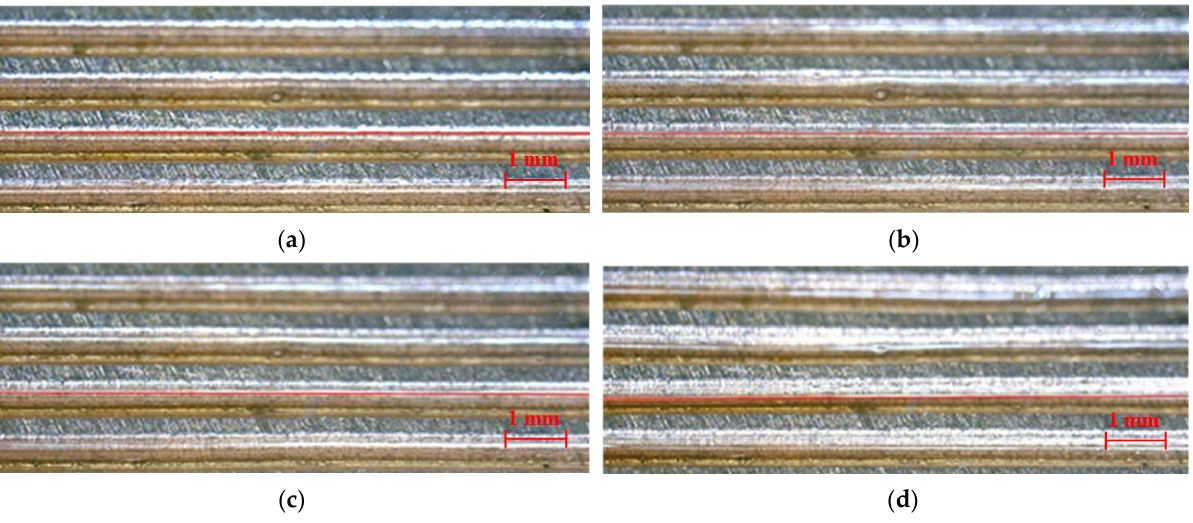
Figure 8. Formation of slope liquid level of the MGFHP filled with anhydrous ethanol under 12 W: ( a ) 1 s; ( b ) 80 s; ( c ) 160 s; and ( d ) 240 s.